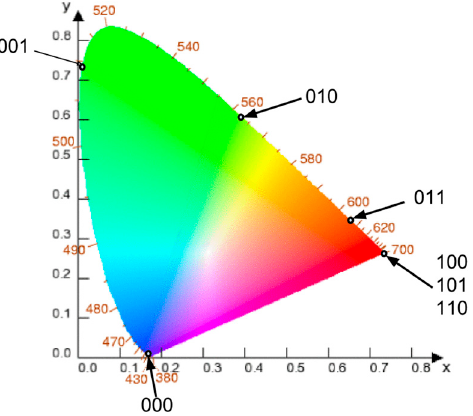
16 of 29 Figure 12. Spectrum of multicarrier modulation scheme ( a ) frequency division multiplexing and ( b ) OFDM, ( c ) a block diagram of OFDM system using N-point FFT and IFFT. From: [119] , Copy- right © 2015 and Imprint. Reproduced by permission of Taylor & Francis Group through PLSclear. 4.5. Color Shift Keying (CSK) Modulation Technique The blue LED chip excites the yellow phosphor to produce white light, but its switching speed capability slows down. Therefore, green, blue, and red are used to achieve white light through light mixing technology. CSK is mentioned in IEEE 802.15.7 and lower data rate is used in other modulation schemes [123]. The modulation of CSK is performed using the intensities of the three colors of RGB LED. CSK is sampled in the color space chromaticity diagram [114]. It maps the eye-perceivable color to two chro- maticity factors, x and y. Table 4 illustrates the seven bands of human-visible wave- lengths, the centers of which are marked in Figure 13. Where 𝑘 is the number of bits ( 𝑘 =